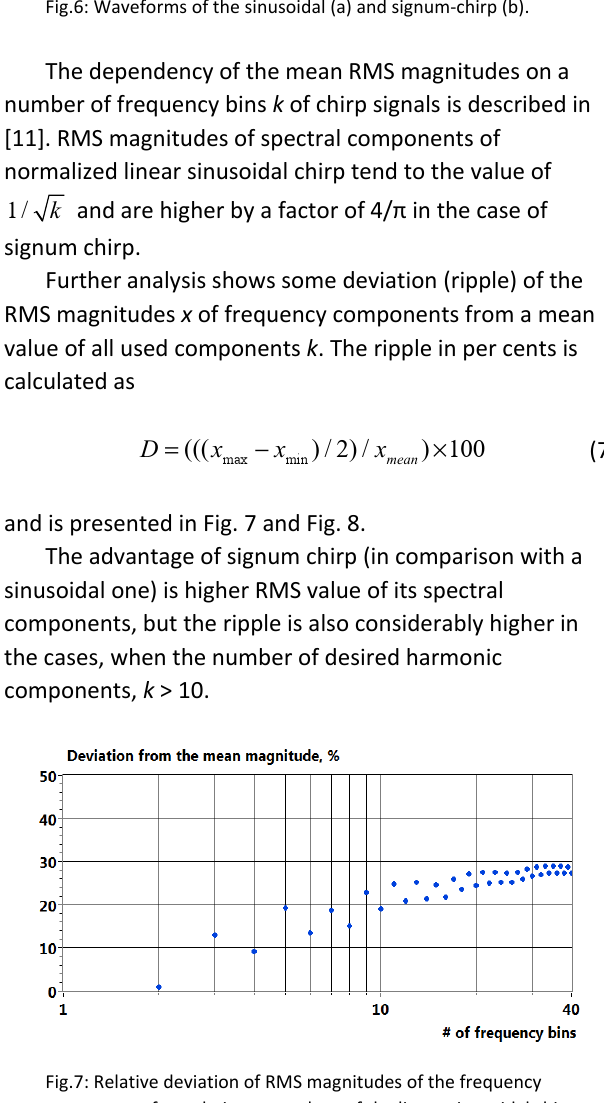
Fig.5: Waveforms (a) and magnitude spectrum (b) of the step waveform with a rise time of 1/500 of the signal period. Note that the first part of the time scale is magnified by 20. Diagonal hatch illustrates the energy content of the signal starting from zero and cross-hatches the energy content of the signal starting from -1.